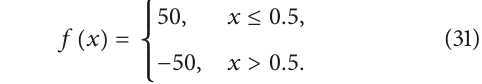
various intensities of reaction ( 𝜎 = 0.1, 1, 10, 20, 50, 100